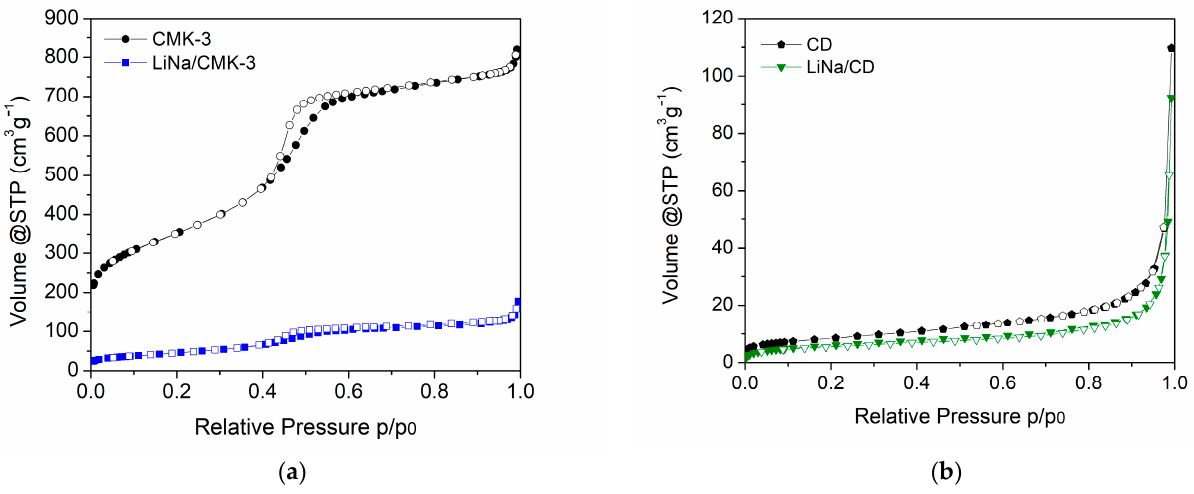
Figure 3. N 2 adsorption/desorption isotherms performed at 77 K ( a ): on the pure CMK-3 type carbon (black) and on the composite material LiNa/CMK-3 (blue), and ( b ): on the pure CD (black) and the LiNa/CD samples (green). Table 1. Surface area (S BET ), total pore volume (TPV) and average pore size (<d>) of pure CMK-3 and carbon discs (CD), as well as their composites with 0.71 LiBH 4 –0.29 NaBH 4 (LiNa).